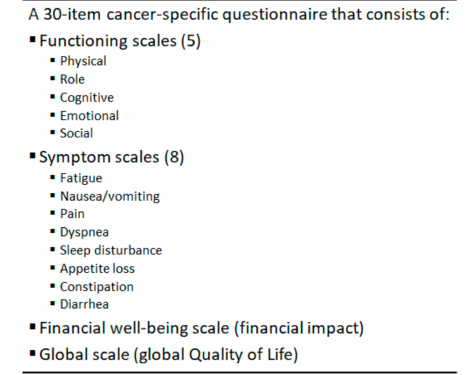
Figure 4. EORTC QLQ-C30: European Organization for Research and Treatment of Cancer Quality of Life Questionnaire Core